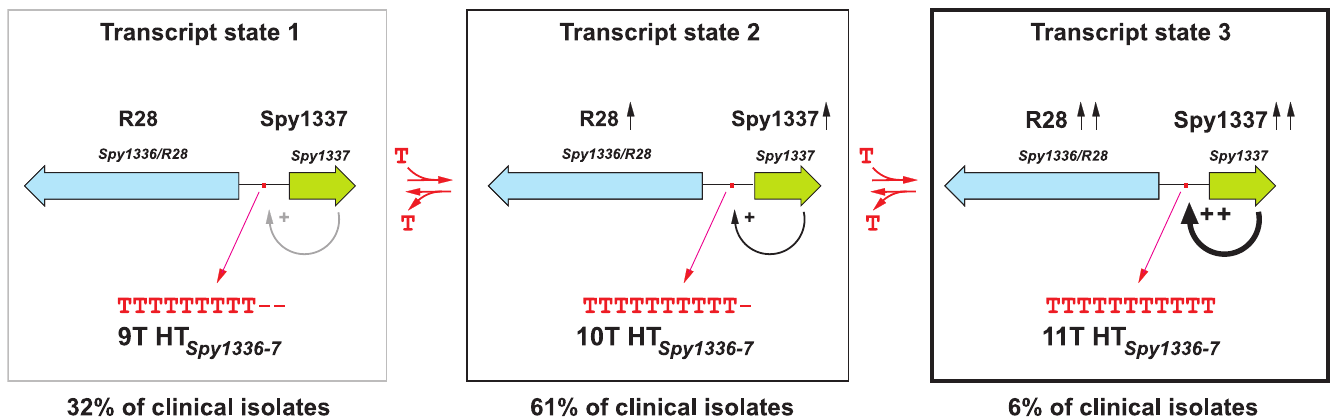
Fig 8. Frequency distribution of HT Spy1336-7 size variants in the emm28 strains studied and effect on Spy1336/R28 and Spy1337 transcript levels. Addition or deletion of one T nucleotide in the homopolymeric tract results in a statistically significant change in transcript levels for Spy1336/R28 and Spy1337 and a consequent effect on virulence. There are three transcript states based on number of T residues in the HT Spy1336-7 region. In state 1 (9Ts, left), there are essentially no detectable transcripts of Spy1336/R28 and Spy1337 . State 2 (10Ts, center) is characterized by increased transcripts of these two genes, and state 3 (11Ts, right) results in further increase in transcripts of Spy1336/R28 and Spy1337